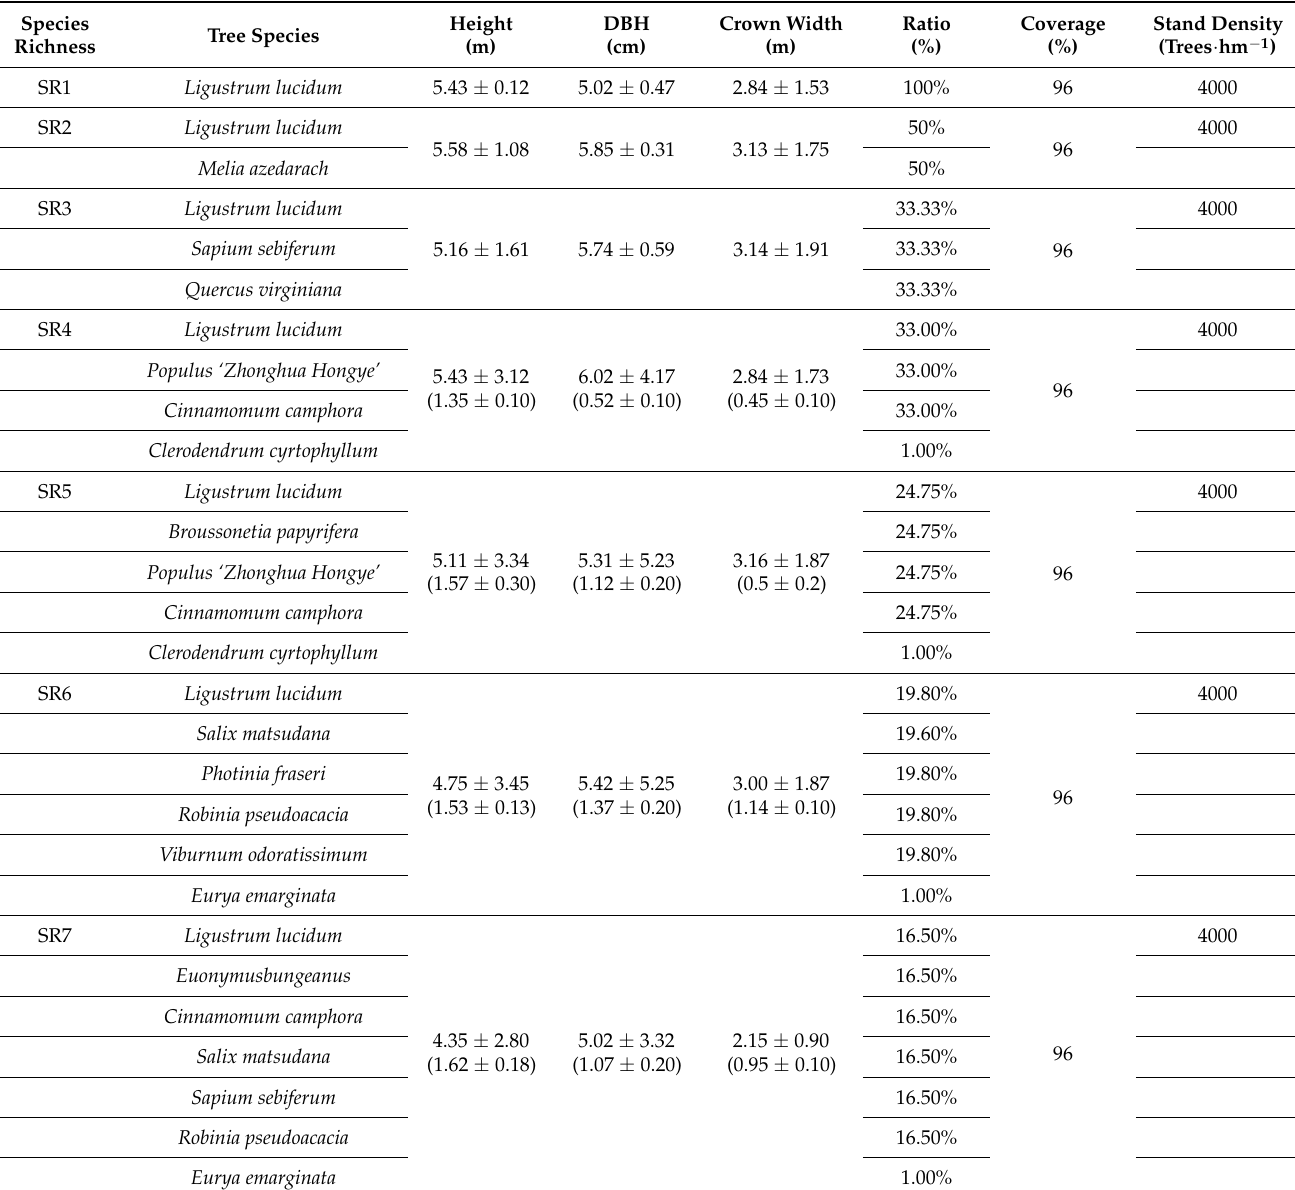
Table 1. Characteristics of plant communities within different tree species